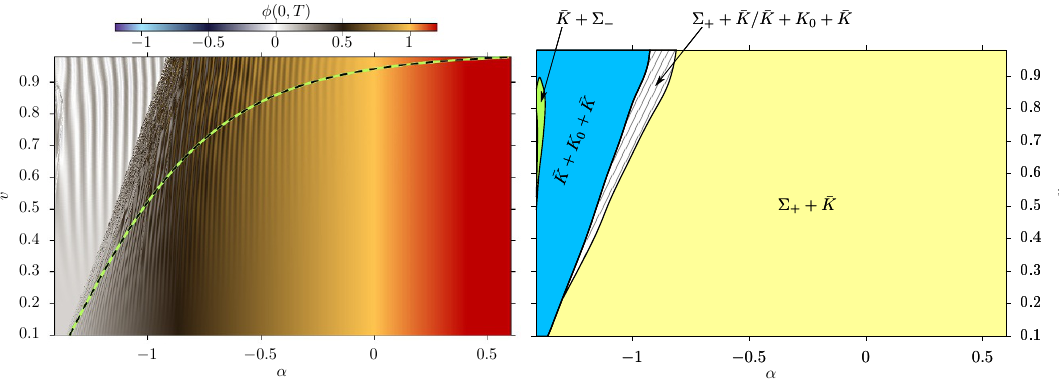
Figure 19 . Di(cid:11)erent scenarios of antikink-impurity ( (cid:22) K + (cid:6) (cid:0) ) collisions. The left plot shows the (cid:12)eld value at center at time T after the collision. The right plot shows the products of the collisions. Line (cid:12)lled regions correspond to chaotic